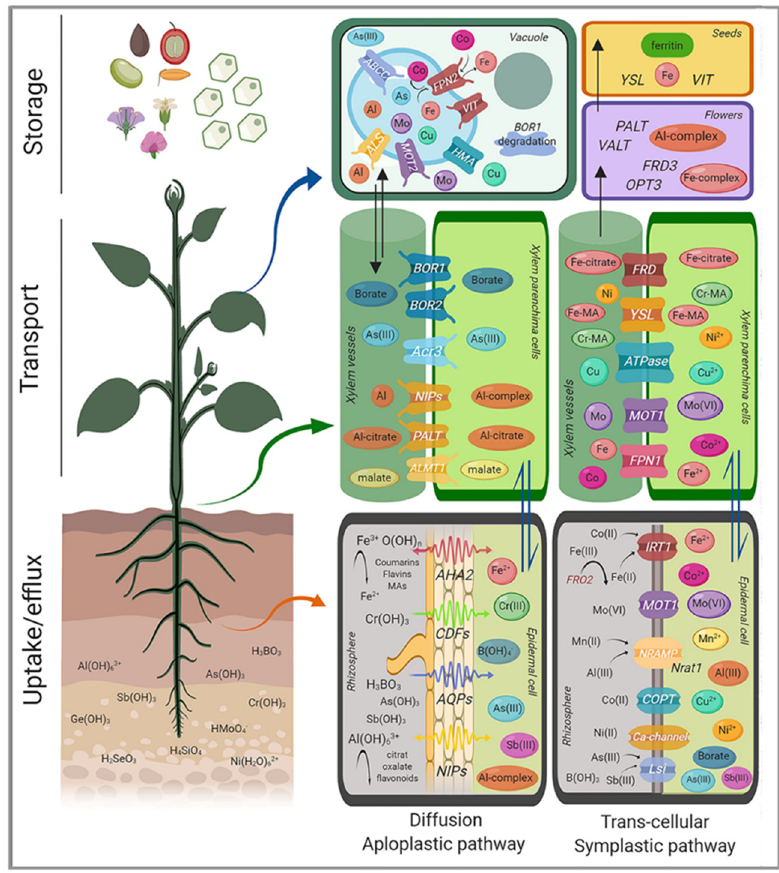
Figure 3. Overview of trivalent elements homeostasis in plants. Uptake systems and main transporters involved in loading, e ffl ux, and storage are indicated for each element: Aluminum (orange), Arsenite (light blue), Boron (dark blue), Cobalt (pink), Copper (turquoise), Chromium (green), Iron (red), Manganese (light yellow), Molybdenum (purple), Nickel (dark yellow), Antimony (violet). AHA, H + -ATPase; CDFs = Cation di ff usion facilitators; AQPs = Aquaporins; LSI, silicon transporter; Mas = Mugineic Acids; NIPs = Noduline Intrinsic Proteins.